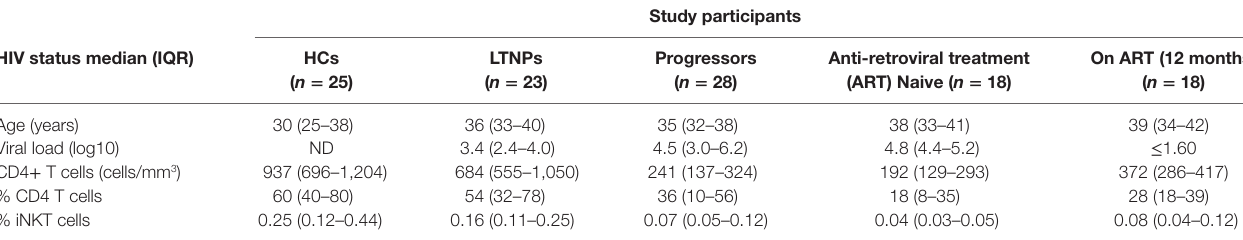
TaBle 1 | Demographic characteristics of study